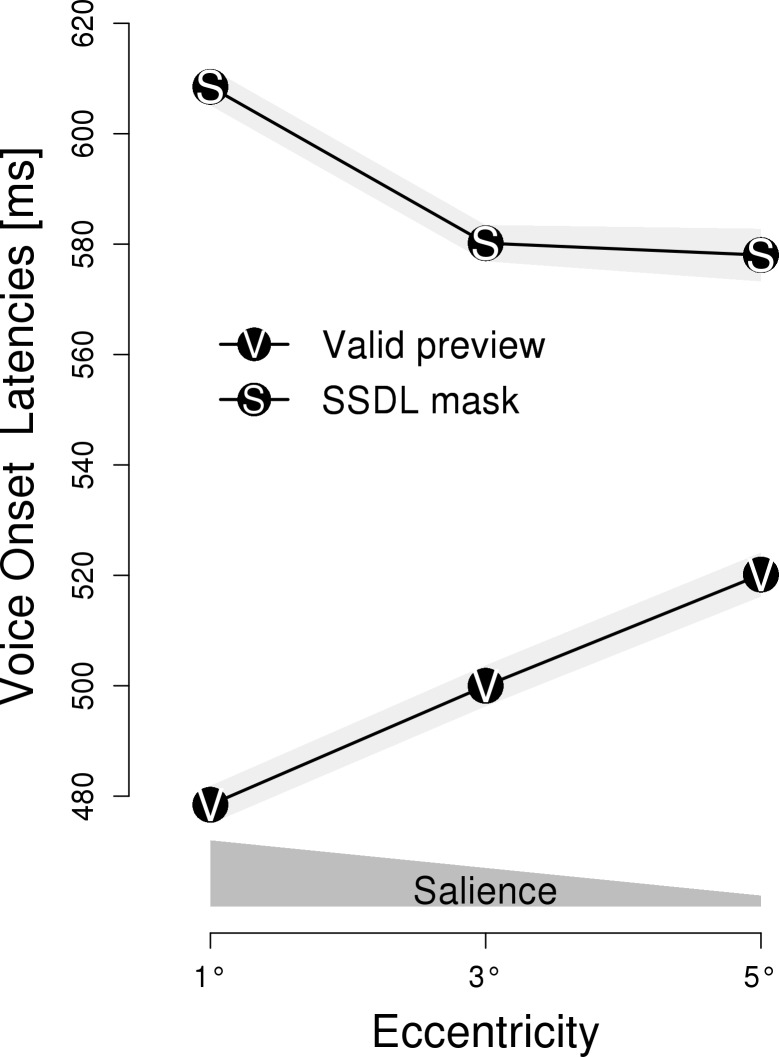
Experiment 1: Mean voice onset latency.Voice onset latencies are depicted in relation to three different eccentricities and are plotted separately for valid previews and same-shape, different letter (SSDL) masks. Polygons represent 1 SEM. The dark gray polygon above the x-axis schematically indicates the level of salience, i.e., the salience is high if the preview is close to the fixation, but decreases when the preview is farther away from the fixation.